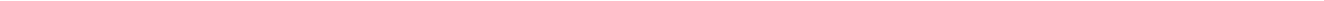
Fig. 4 C1q reduction causes defective efferocytosis by Mafb − / − macrophages. a Apoptotic Jurkat cells treated with CellTracker were incubated with Mafb − / − fetal liver-derived macrophages in 0, 20, and 50% serum from WT mice (0%, n = 4; 20%, n = 3; 50%, n = 4). b Apoptotic Jurkat cells were incubated with Mafb − / − macrophages with 50% WT serum and a different time course ( n = 4 for each group). c Apoptotic Jurkat cells were incubated with or without heat-inactivated serum or normal serum (serum-, n = 5; inactivated serum, n = 5; serum, n = 3). a – c The data are from one experiment that was representative of at least two independent experiments. d Apoptotic Jurkat cells were incubated with Mafb − / − macrophages with or without C1q-de fi cient serum or WT serum (WT, n = 6; Mafb − / − , n = 10 for each sample). e Apoptotic Jurkat cells were incubated with Mafb f/f ::LysM-Cre fetal liver-derived macrophages that treated with or without 100 μ g of puri fi ed human C1q 1 h before ( Mafb f/f , n = 3; Mafb f/f ::LysM-Cre, n = 10; Mafb f/f ::LysM-Cre + C1q, n = 10). d , e The results are from two pooled independent experiments. a – e Quanti fi cation data are presented as the mean ± s.e.m.; ** p < 0.01, n.s.